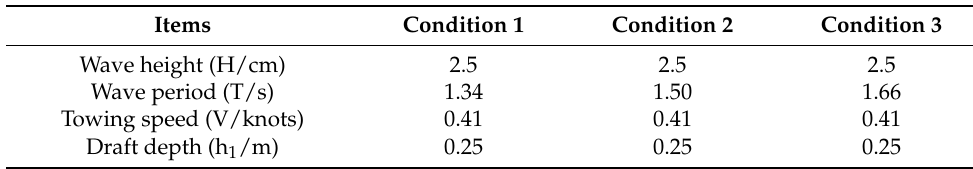
Figure 19. The dynamic response of the TBJF for different wave heights. ( a ) Towing force. ( b ) Pitch. ( c ) Bucket 1 pressure. ( d ) Bucket 2 pressure. Table 10. Towing conditions for different wave